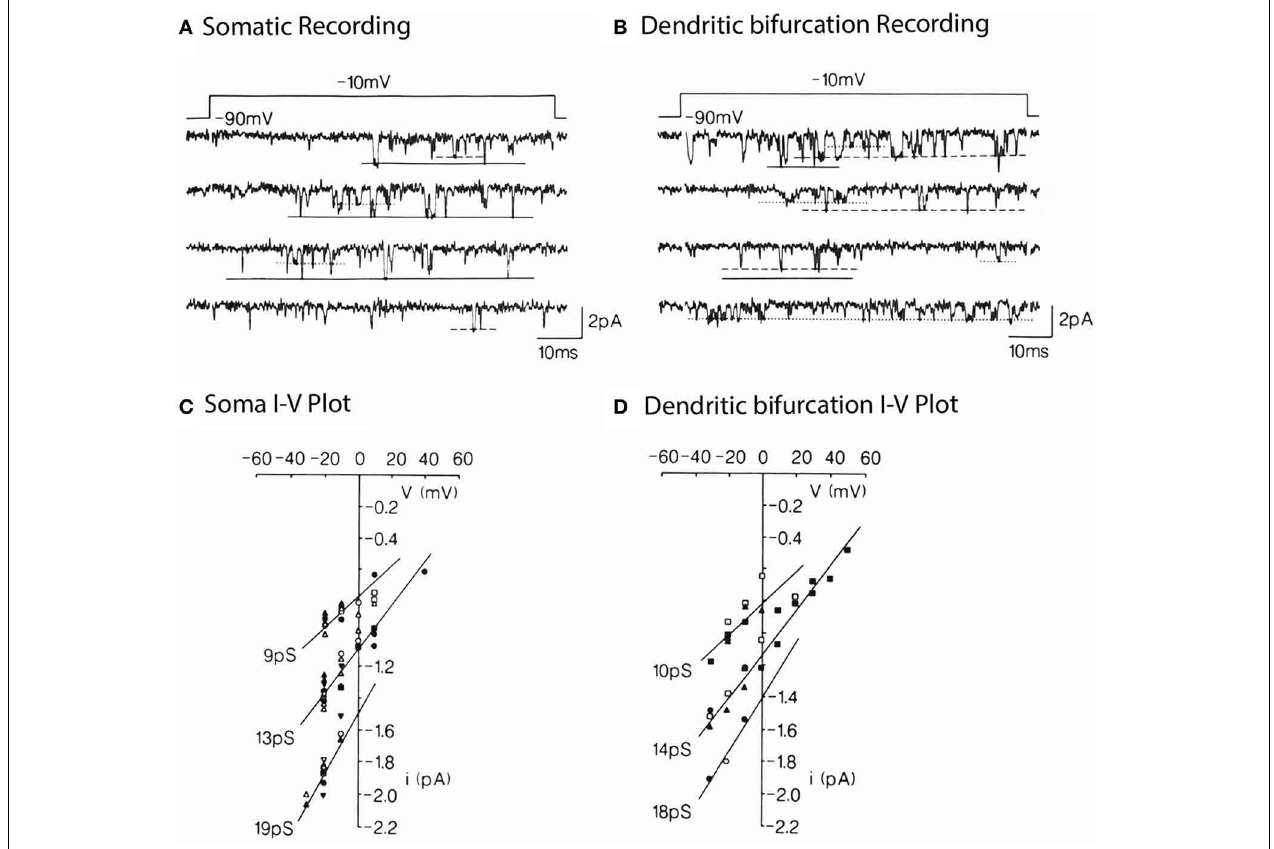
FIGURE 4 | Multiple conductance of Ca 2 + channels in the somata and dendrites of cerebellar Purkinje cells. (A) Single Ca 2 + channel currents carried by 110mM Ba 2 + in a somatic patch, evoked by voltage step jumps ( ≈ 70ms) applied once every 5s. Three opening levels are indicated by solid,